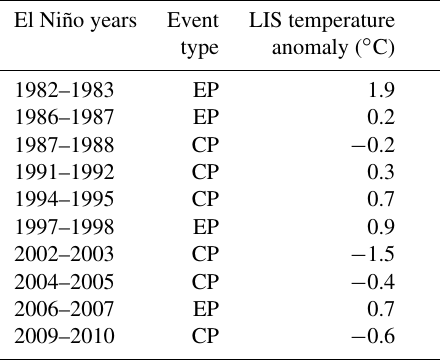
Table 5. El Niño events partitioned into central (CP) and eastern (EP) Pacific types based on the categorization method of Yu et al. (2012). El Niño events are defined based on the DJFM season. The third column provides the corresponding DJFM LIS tempera- ture anomaly. A more complete table of El Niño events can be found in Johnson and Kosoka